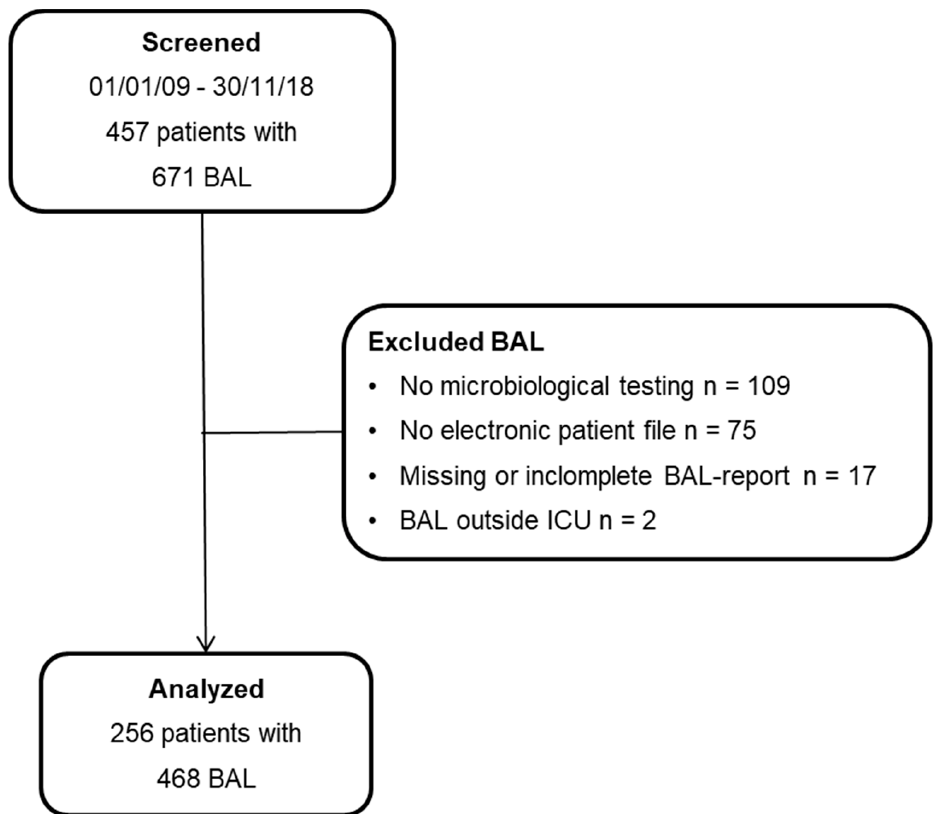
Figure 1. Patients included. Flow chart showing patients undergoing bronchoalveolar lavage (BAL) who were screened and finally included in the registry. Table 1. Patient characteristics. Table 2. Outcomes of microbiological cultures. Whole Population Number of BAL